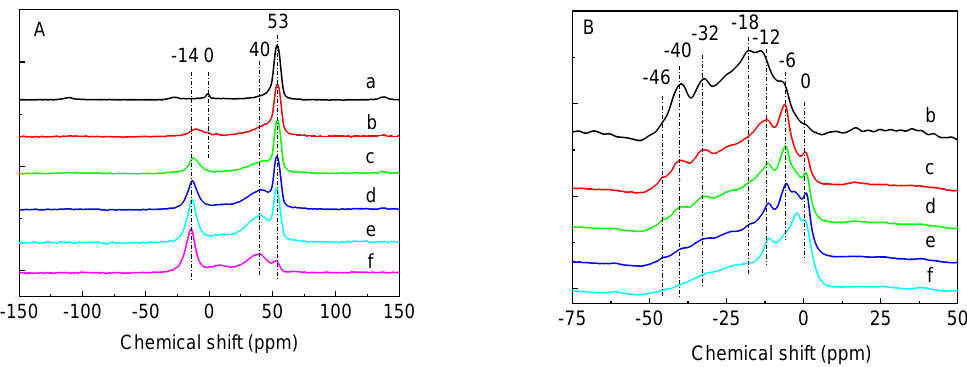
Figure 6. 27 Al MAS NMR spectra ( A ) and 31 P MAS NMR spectra ( B ) of parent and P-modified HZSM-5 zeolites: ( a ) HZSM-5, ( b ) 0.5% P / HZSM-5, ( c ) 1% P / HZSM-5, ( d ) 2% P / HZSM-5, ( e ) 3% P / HZSM-5 and ( f ) 5% P / HZSM-5.